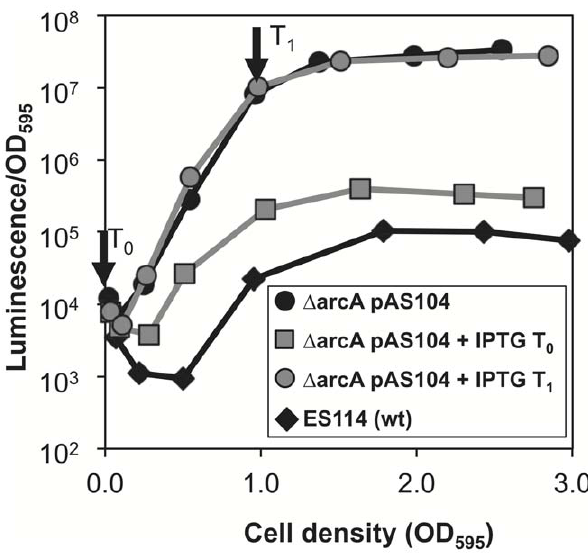
Figure 3. Effect of controlled ArcA expression on biolumines- cence. Cultures of either the D arcA mutant with the inducible- arcA vector pAS104 (circles and squares) or wild type (diamonds) were grown in SWTO medium in duplicate aerobic shake flasks. Specific luminescence (luminescence per OD 595 ) was observed for cultures grown with no addition (black) or with 2 mM IPTG added at the time of inoculation (T 0 , gray squares) or when cultures reached an OD 595 of , 1.0 (T 1 , gray circles).